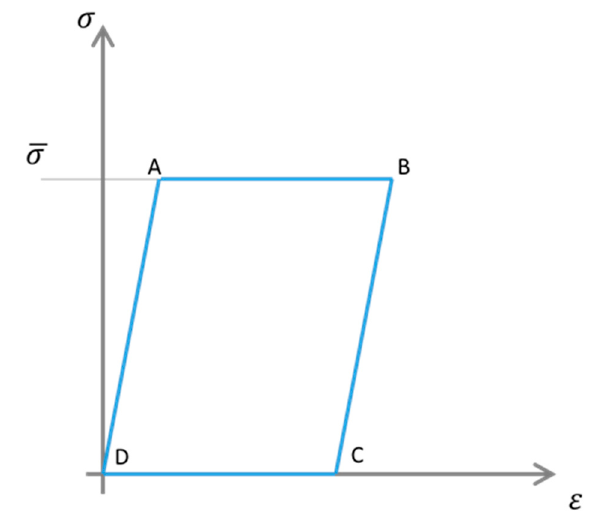
Figure 4. Scheme of the thermomechanical process simulated.